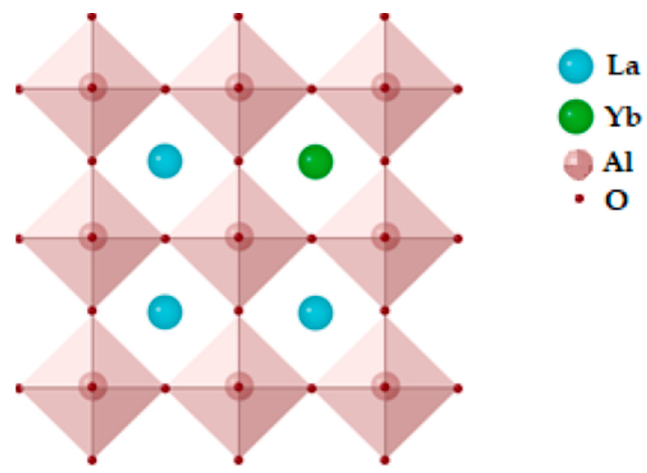
Figure 4. La 0.85 Yb 0.15 AlO 3 structure.